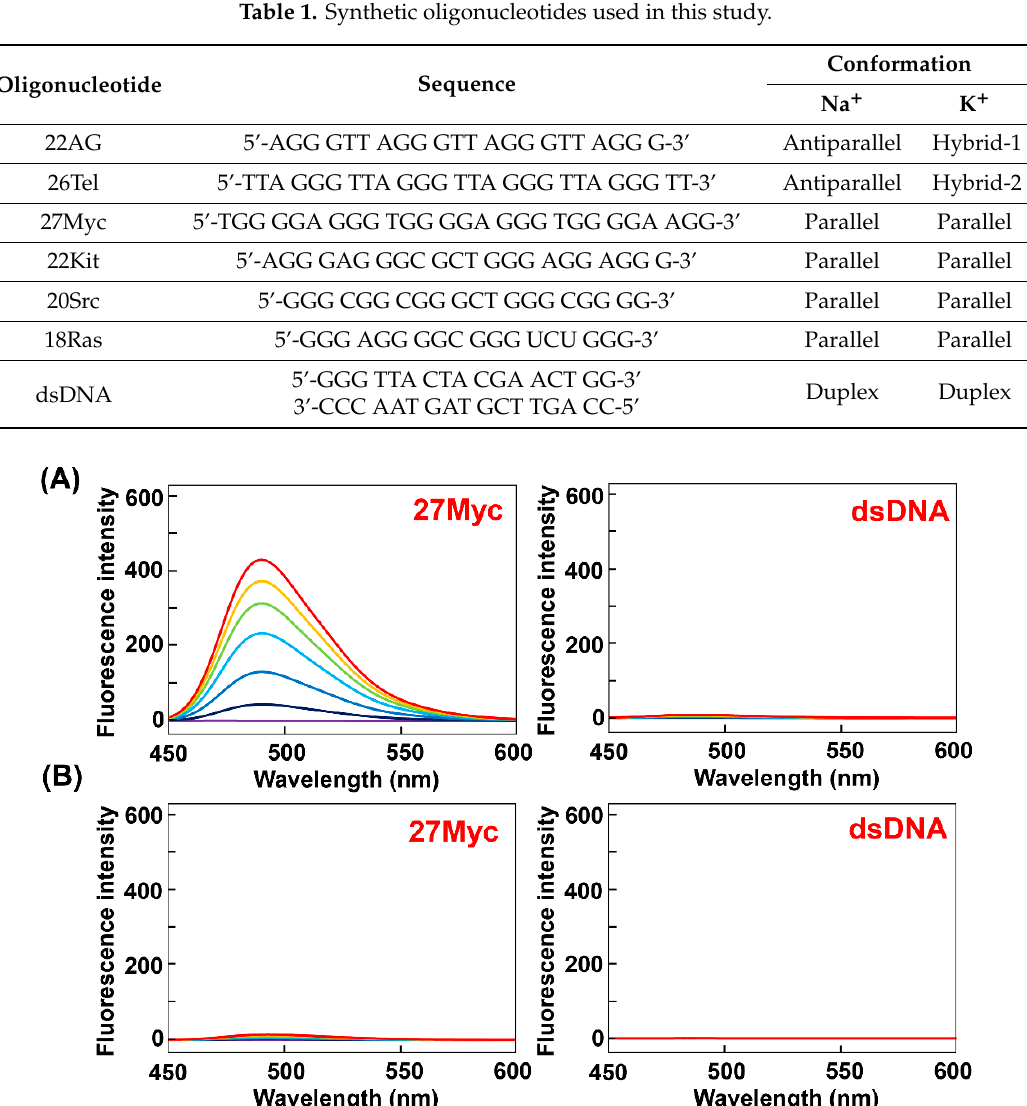
Figure 4. Fluorescence spectra of ( A ) ThT-HE and ( B ) ThT-AE (3 µ M) in PBS140KM with increasing concentrations of 27Myc (left side) and dsDNA (right side) (0, 1, 3, 6, 9, 12, and 15 µ M). Oligonucleotide concentration: 0 µ M (purple), 1 µ M (navy blue), 3 µ M (blue), 6 µ M (light blue), 9 µ M (green), 12 µ M (yellow), and 15 µ M (red).